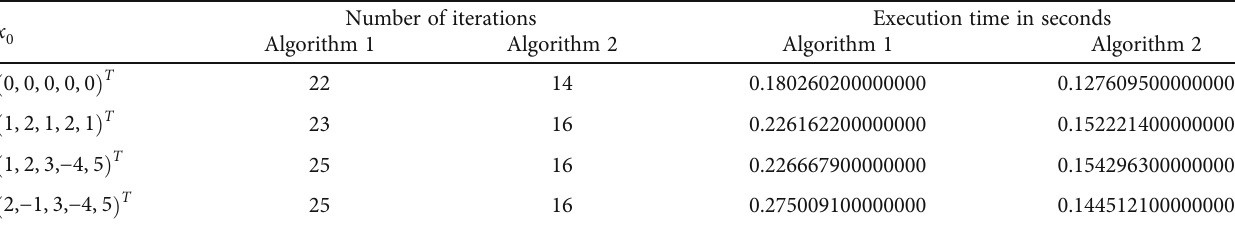
Table 1: All methods ’ numerical values for Figures 1 – 8.